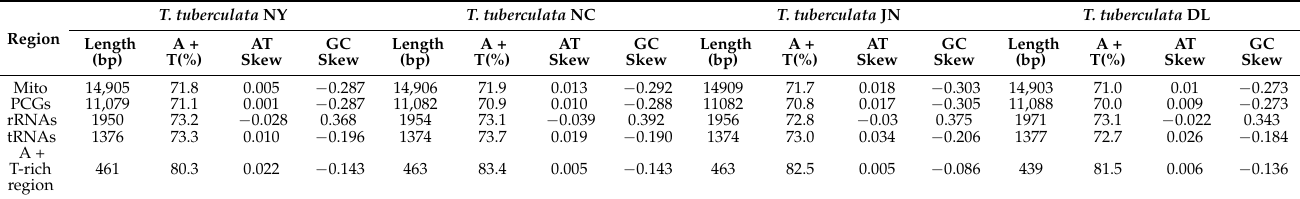
Table 3. Base composition of the mitochondrial genomes of the T. tuberculata from four